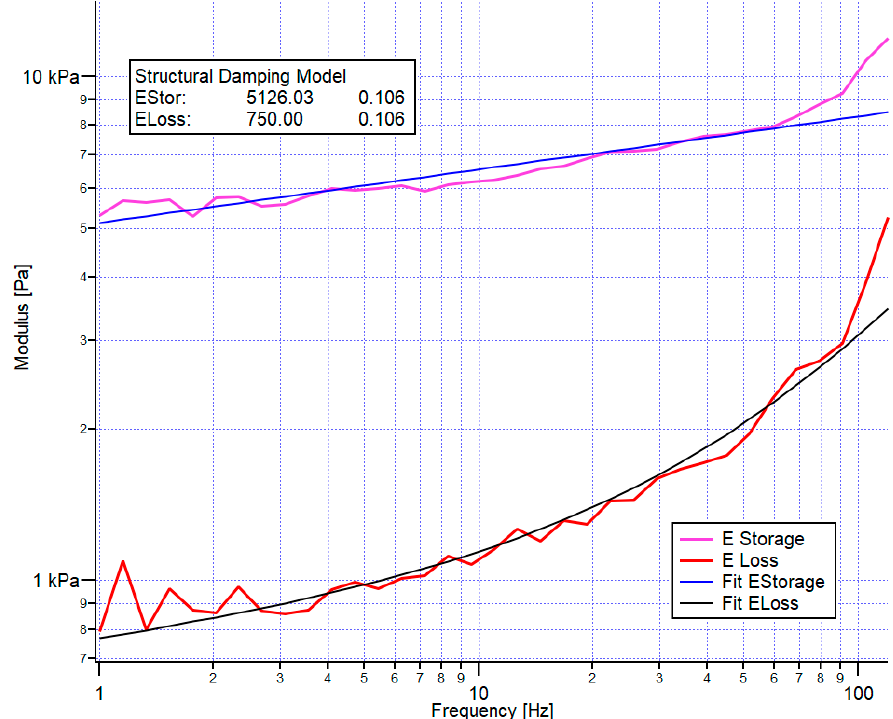
Figure 3. An example of the loss and storage modulus versus frequency obtained by the frequency sweep. A power-law fit is applied to the storage modulus, whereas the structural damping model is used to fit the loss modulus. Both fit procedures result in a storage and loss modulus value for the lowest frequency (here, 1 Hz). Presently, 5126 Pa and 750 Pa are shown, respectively, and a power-law exponent of 0.106.